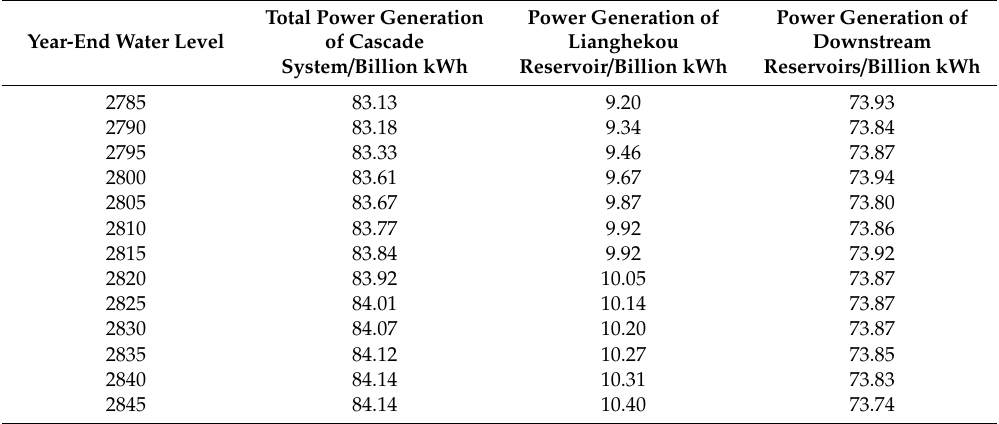
Calculation results of the first dry year under di ff erent year-end water levels of Lianghekou reservoir.